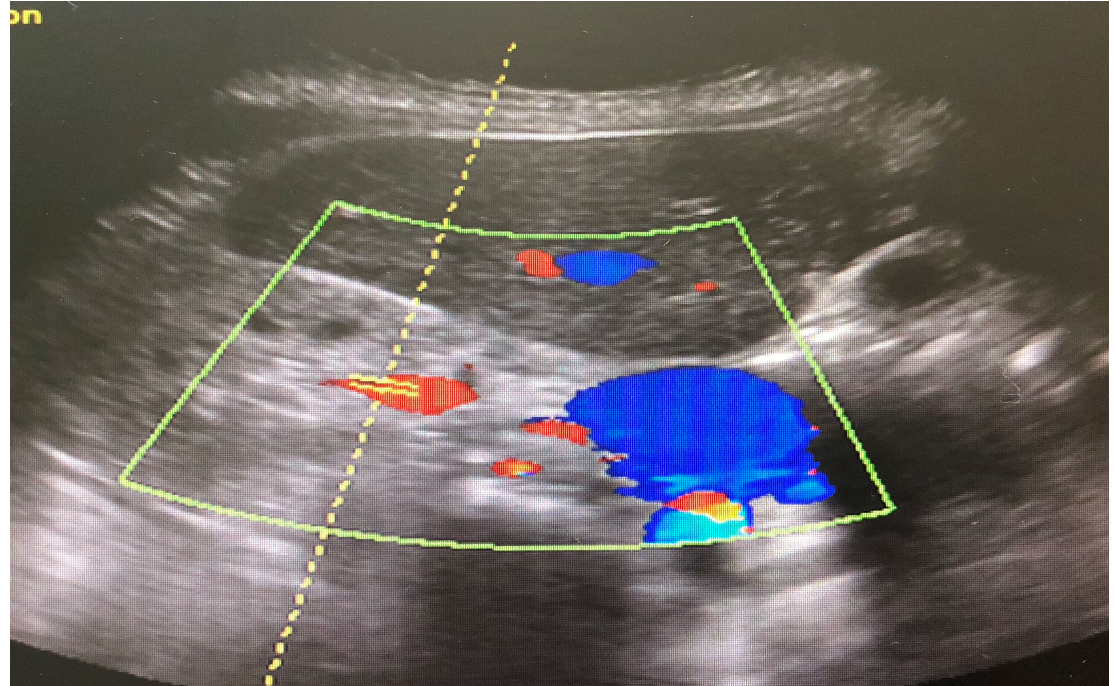
Figure 4: Renal Doppler ultrasound: abnormal resistive index bilaterally with abnormally echogenic kidney, suggestive of medical renal